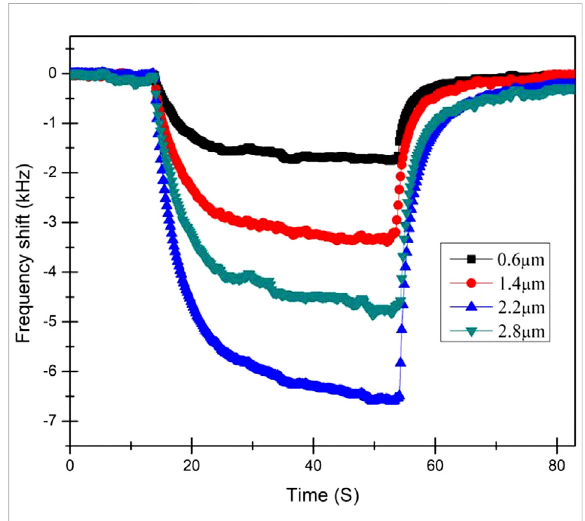
FIGURE 4 Sensor responses toward 4.0 ppm formaldehyde for samples with different fi lm thickness at 120 ° C.